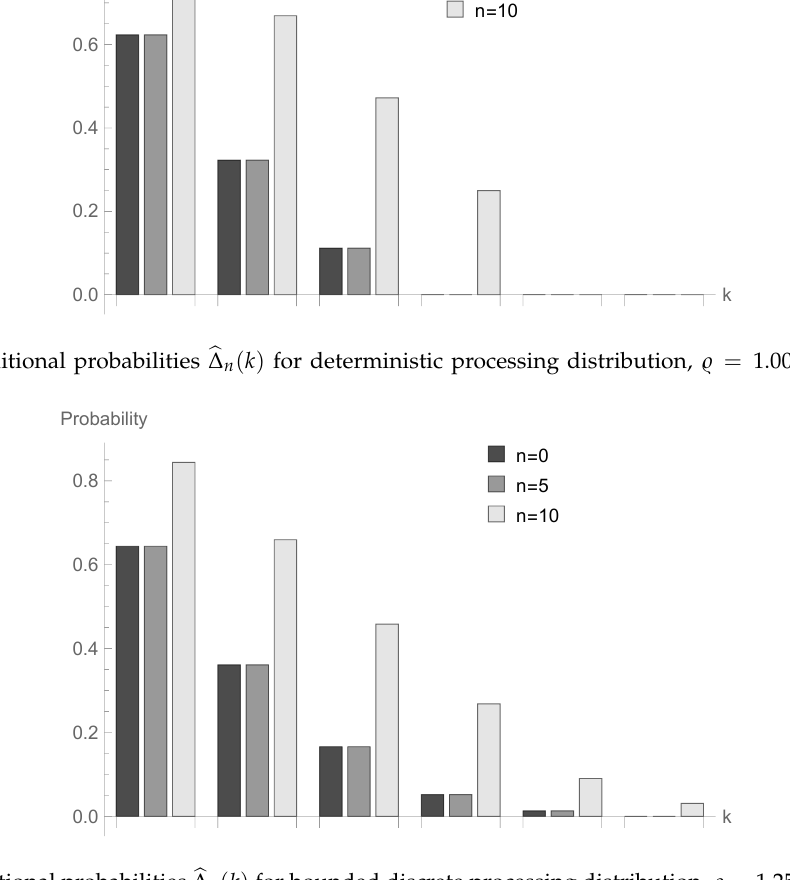
Figure 9. Conditional probabilities (cid:98) ∆ n ( k ) for bounded discrete processing distribution, (cid:36) = 1.25 and n = 0,5 and